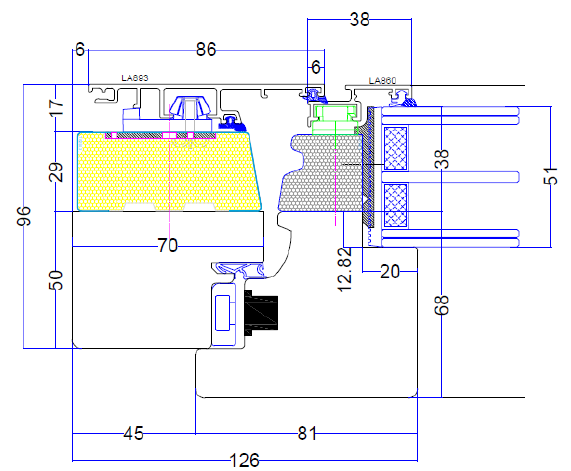
Figure 1. Cross section of the frame reporting dimensional data of the reference window frame, corresponding to a window designed in compliance with regulations. Above, the external aluminum section is clearly visible; in the intermediate part, the area devoted to thermal insulation (in yellow); below, the wooden profile, facing the indoor space.